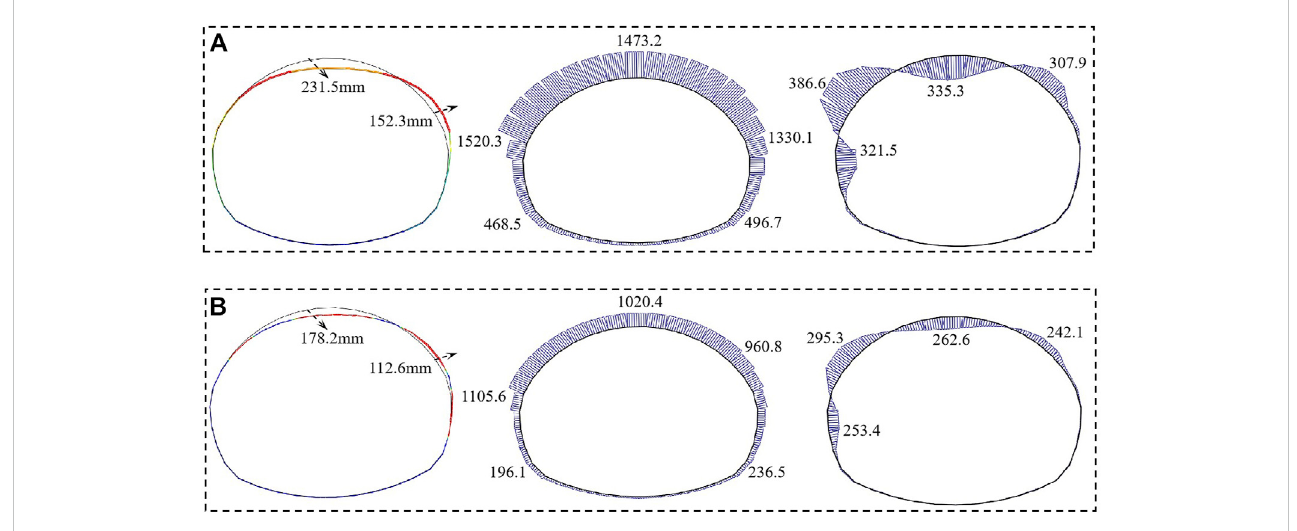
FIGURE 12 Deformation and internal force of primary supports: (A) original construction scheme and (B) improved construction